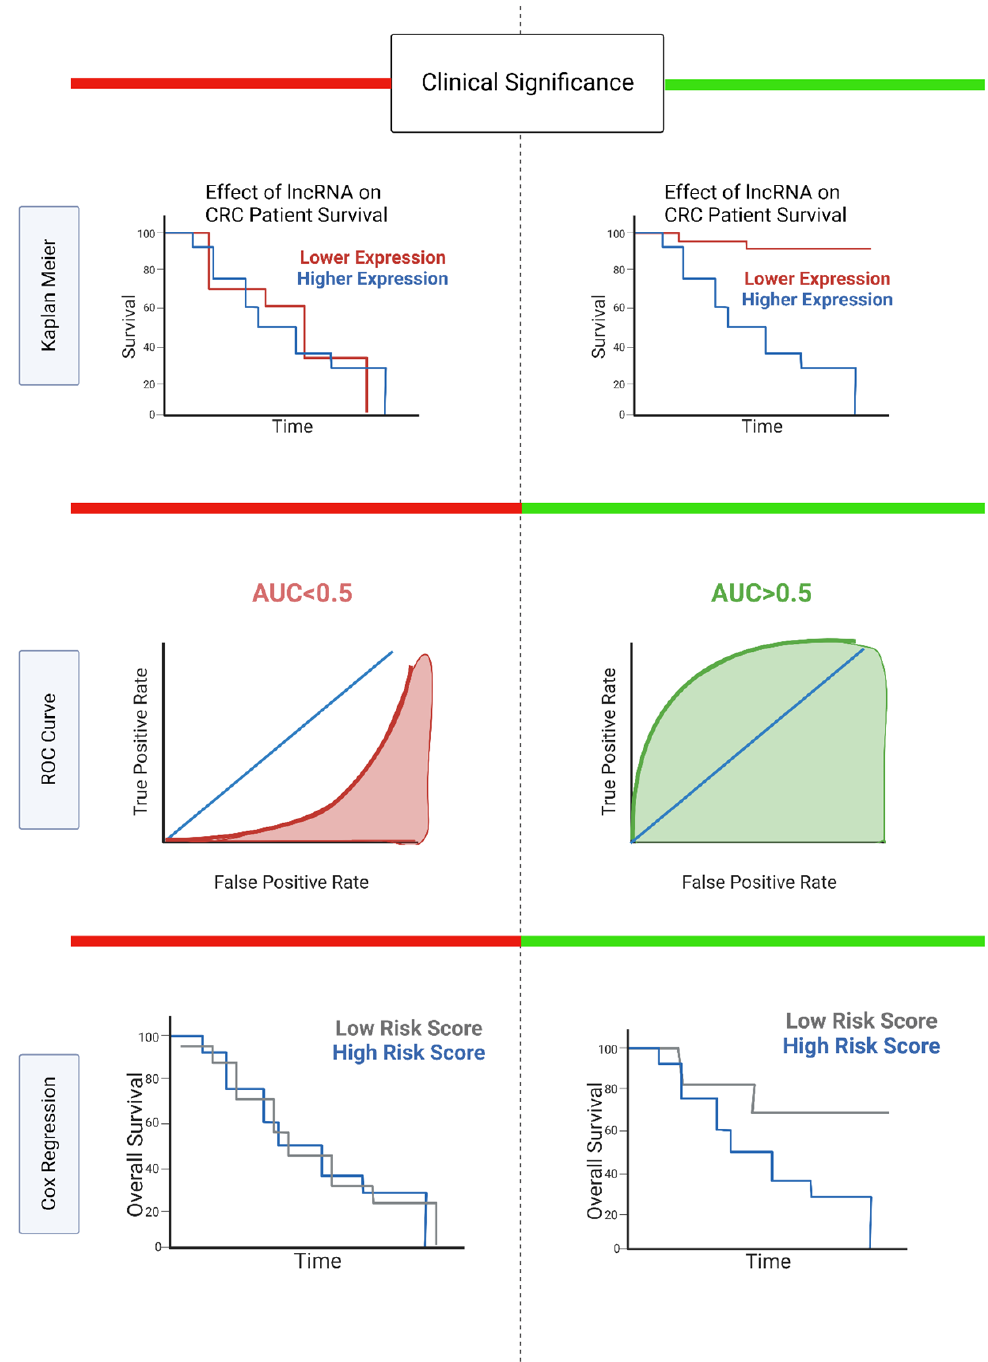
Figure 3. Evaluating clinical and prognostic significance of lncRNAs in CRC. Both insignificant ( left , in red ) and significant ( right , in green ) example graphics for Kaplan–Meier survival analysis, ROC curve analysis, and Cox regression analysis are shown. Created using